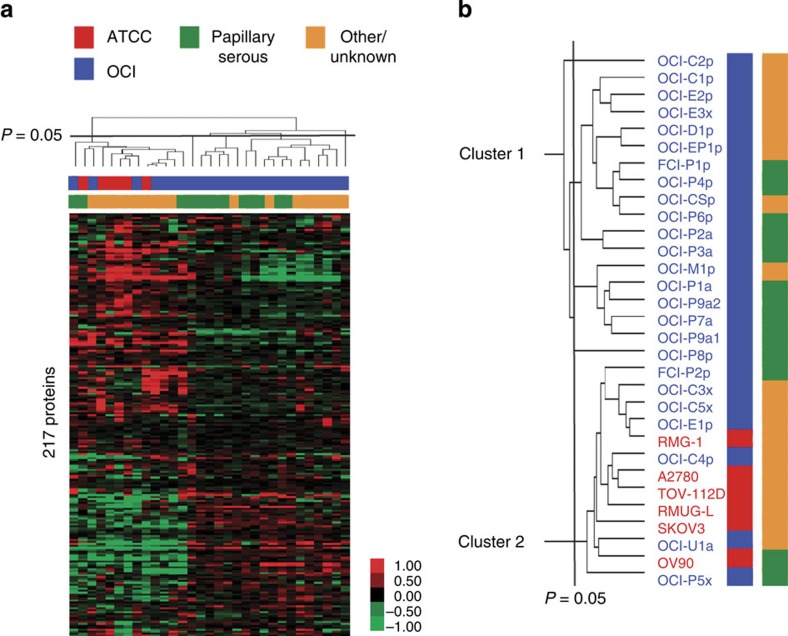
The proteomic profiling of OCI cell lines identifies two major clusters.(a) The unsupervised clustering of protein expression (measured by RPPA) in OCI cell lines (blue bars) together with SOC ovarian cancer cell lines (red bars) reveal two distinct clusters. Rows represent cell lines and columns represent antibody probes for each protein. The red and green colours reflect relative high and low expression levels, respectively. As in the mRNA clustering, cluster 1 contains only OCI cell lines (top half of the heatmap, blue only), and cluster 2 contains a mixture of SOC and OCI cell lines (bottom half of the heatmap, red and blue). While the papillary serous histotype almost exclusively aligns within cluster 1 (green bars), the non-papillary serous subtypes (orange bars) are divided between cluster 1 and cluster 2. (b) The dendogram of the cell lines that make up the two clusters in a. The cell line names are coloured as follows; papillary serous (green) and other histotypes (orange). See Supplementary Methods, Supplementary Figs 12–14, Supplementary Tables 12 and 13 and Supplementary Data 4 and 5 for more detailed information.